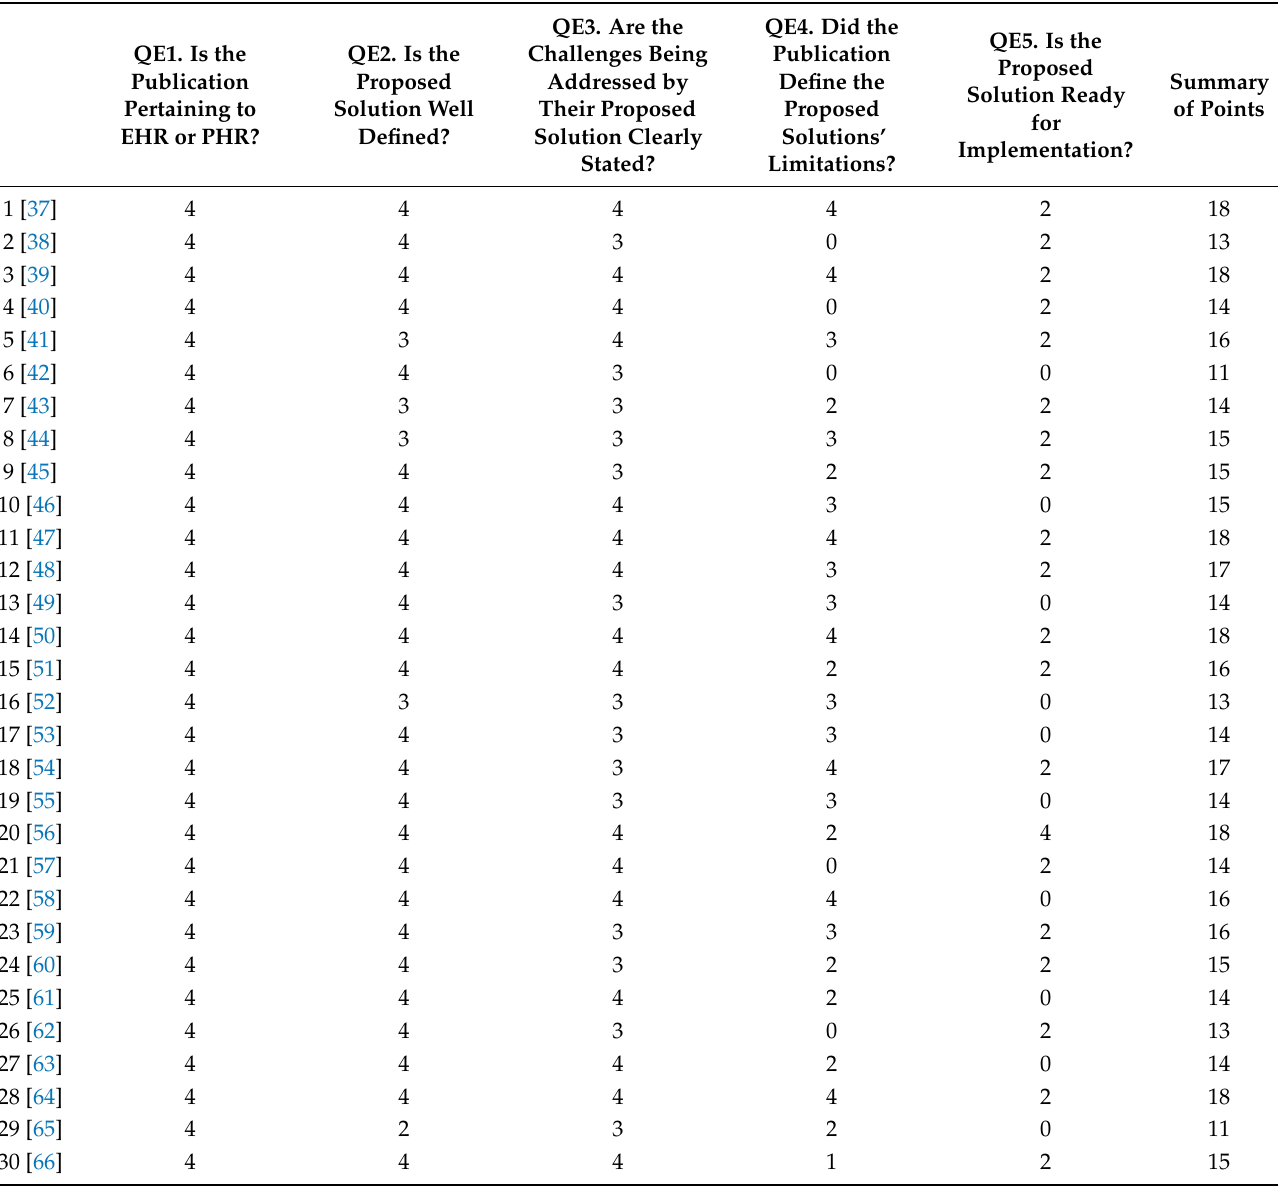
Table 4. Summary of scores for assessing the quality of